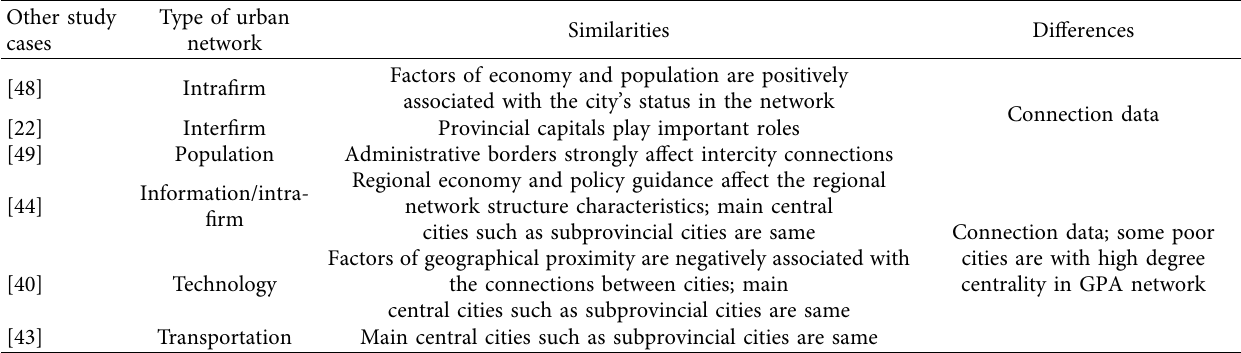
Table 9: Comparison with other urban network